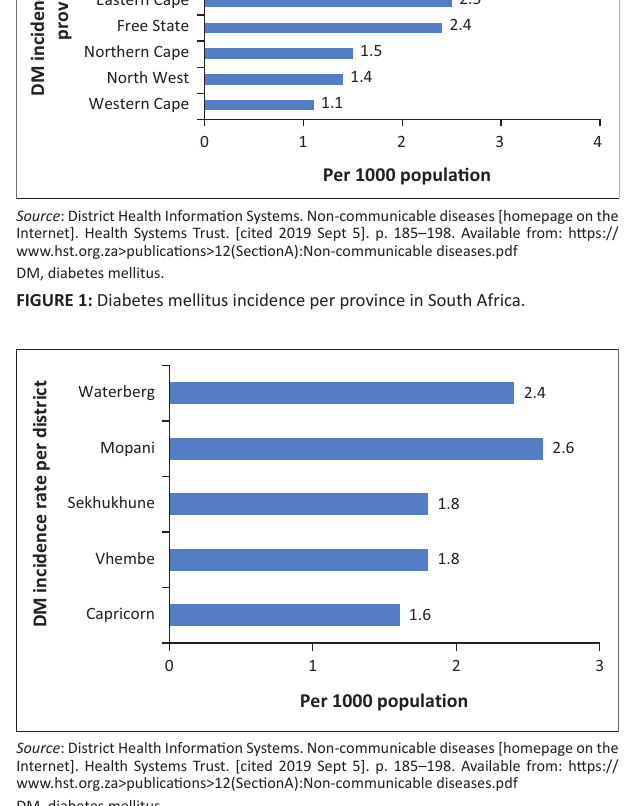
FIGURE 2: Diabetes mellitus incidence per district of the Limpopo Province of South Africa.